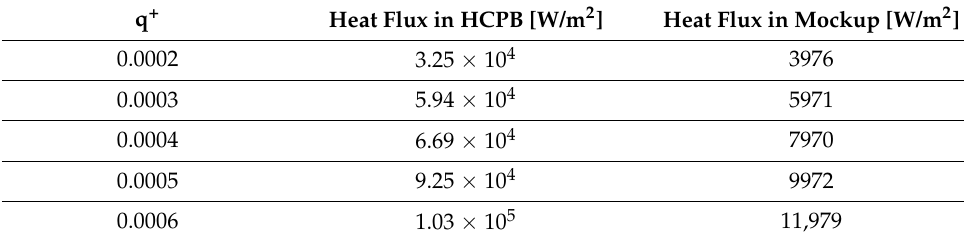
Table 1. Heat flux comparison at same q + of selected Re number.